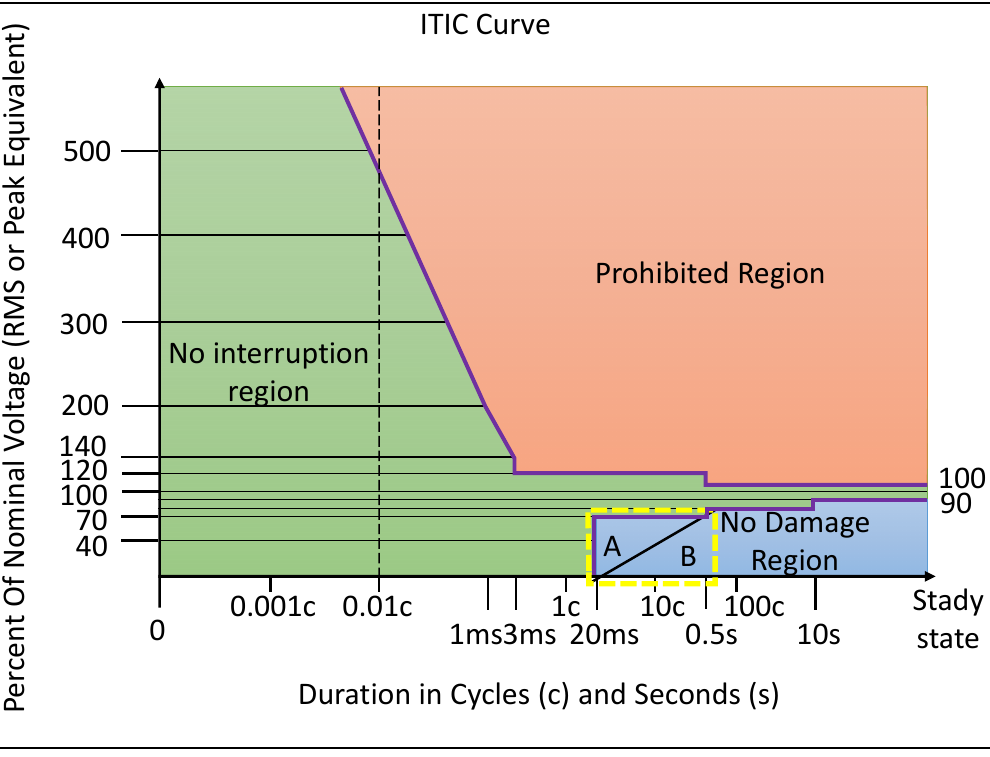
Figure 1. ITIC/SEMI F47 curve describing the permissible range of changes in the voltage supplying the IT device as a function of time (the area marked with a dashed yellow line revealed the forbidden states).